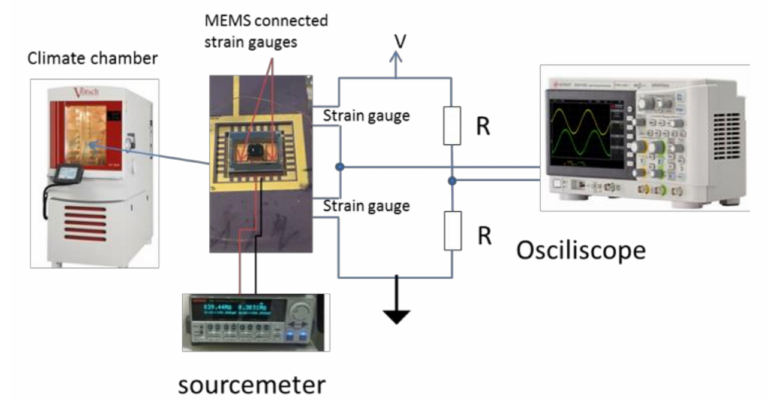
Figure2. Experimentalsetup, composedofahumiditychambertocontrolthehumidityandtemperature applied to the MEMS. The output was registered by a sourcemeter and an oscilloscope, to obtain the resistance of the GO / PVA film and the oscillation frequency of the bridge, respectively. The voltage V is a DC voltage of ~5 V, in order to have the maximum sensitivity. The configuration of the bridge is a full bridge; in particular, two discrete resistors and two integrated strain gauges (embedded in two crab-leg springs) have been used, respectively.